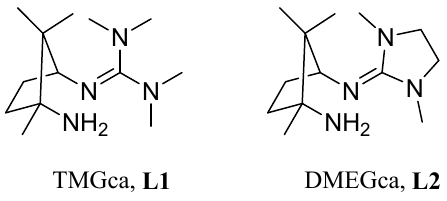
Figure 1. Overview of the utilized monoamine-guanidine hybridligands L1 [75] and L2 .